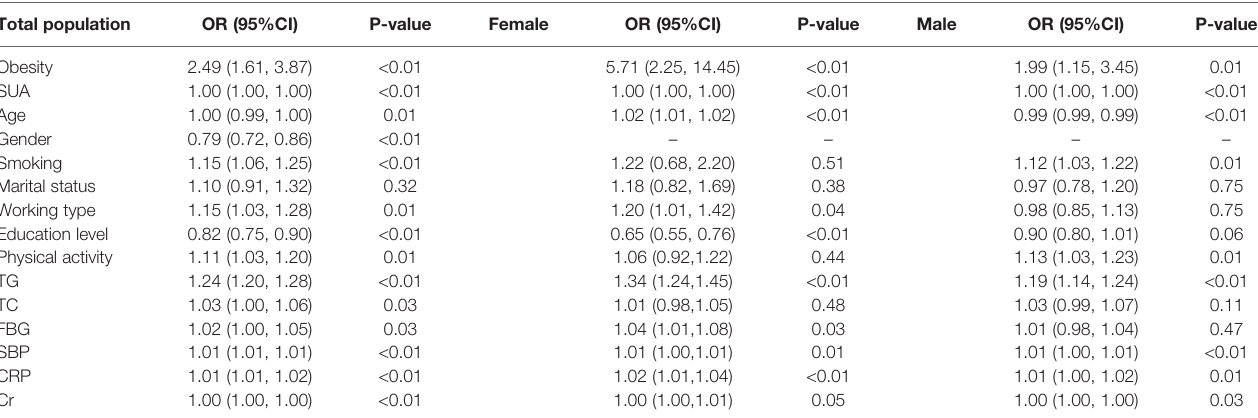
TABLE 4 | Logistic regression for the association of obesity, SUA and NAFLD divided by gender. Total population